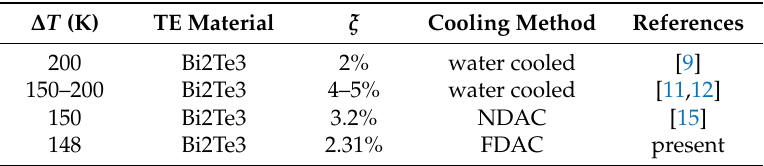
Table 3. Thermoelectric efficiencies of various